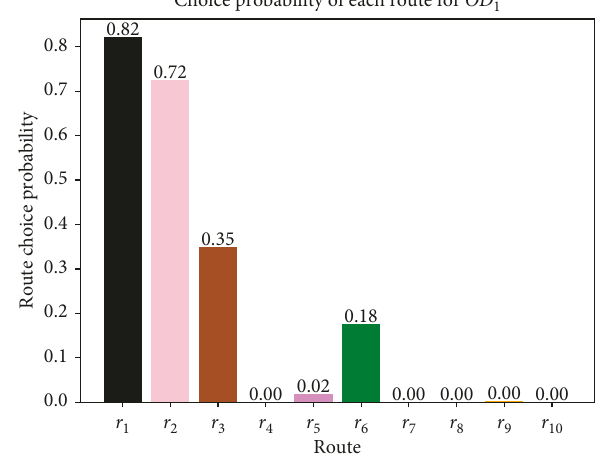
Figure 6: The route choice probability of each route in OD